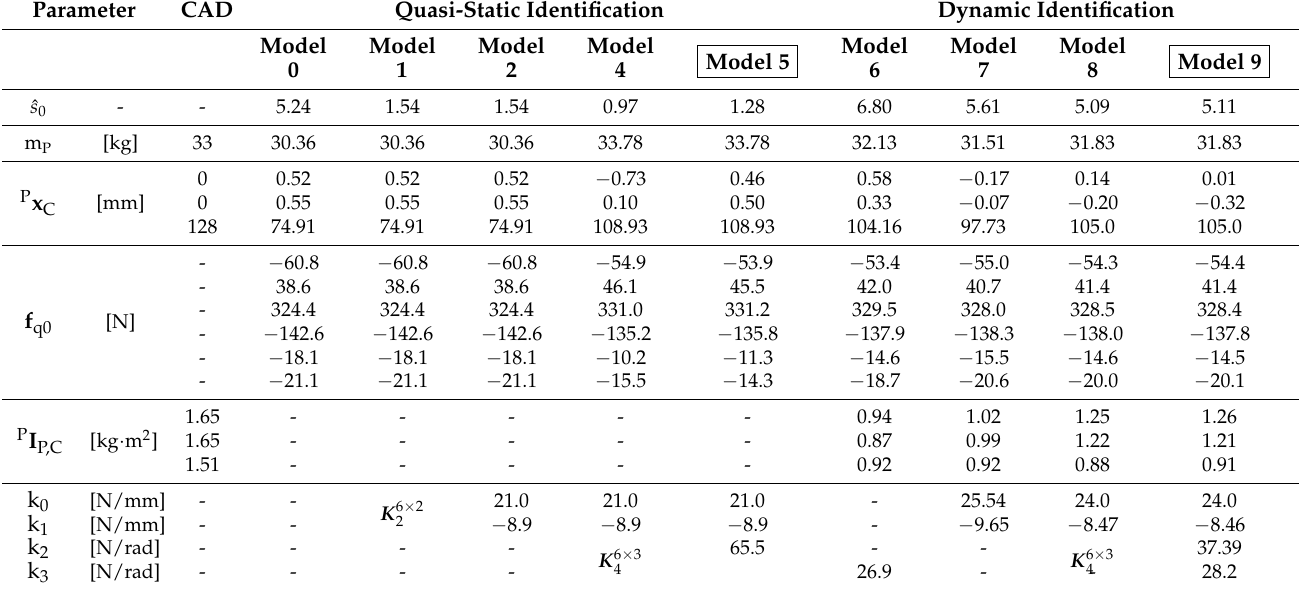
Table 3. Identification results for different modelling approaches, as listed in Table 2. Model 3 is not identifiable. Quasi-static results are based on measurements with 480 poses (Section 6). Dynamic results are based on manually chosen trajectory (Section 7). CAD: A-priori values from geometric design. In squares: selected models for excitation optimisation. Parameter